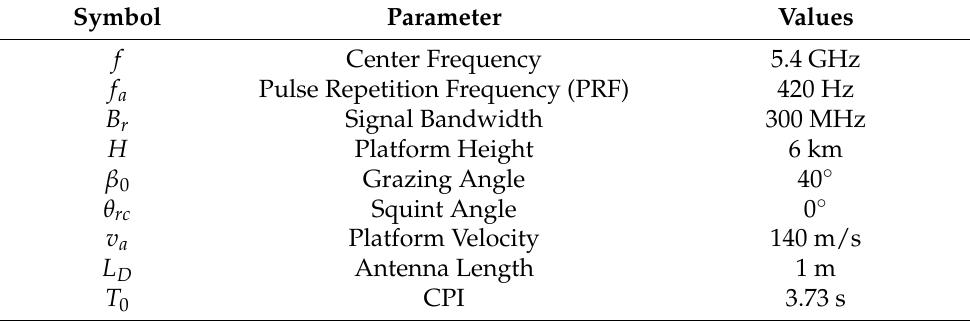
Table 4. The system parameters of SAR